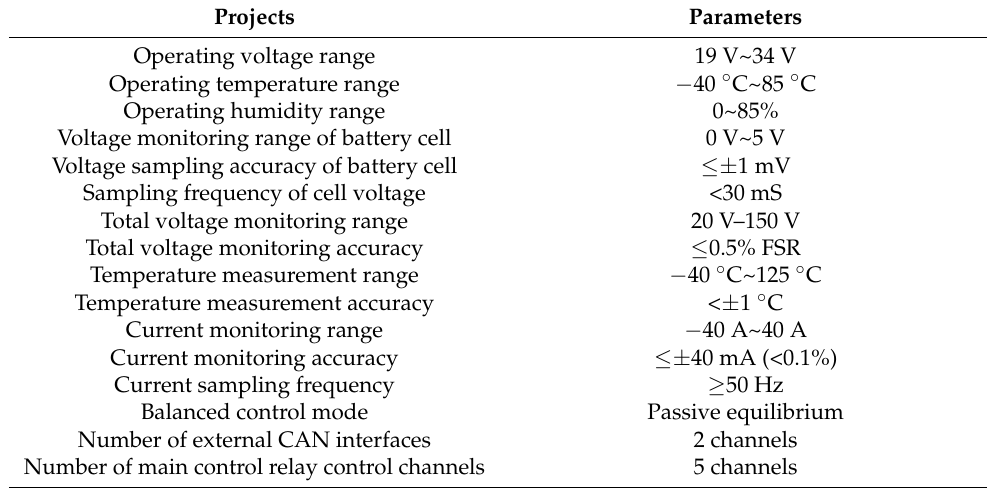
Table 1. The functional parameters of the BMS slave monitoring circuit.